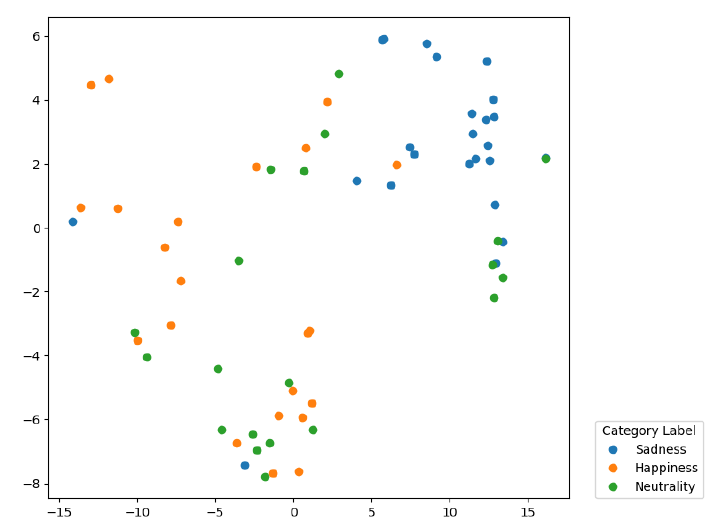
Figure 15. Visualization for distributions of deep emotion features of the model with CMED on